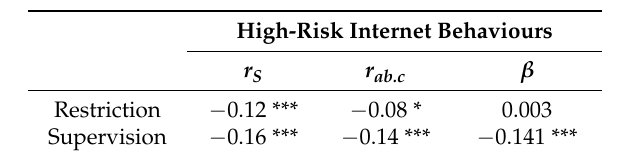
Table 2. Correlation between scores for parental internet restriction and supervision and adolescent high-risk Internet behaviours ( N =